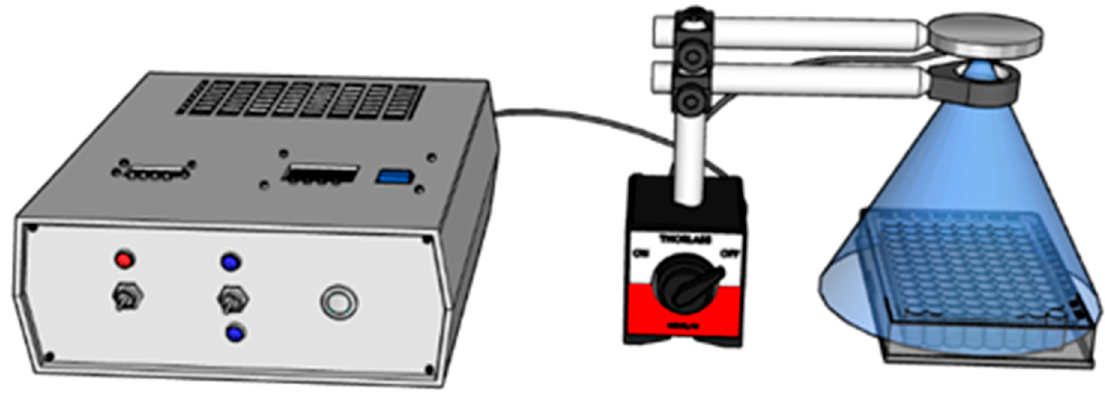
Figure 2. LED Irradiation experimental setup.